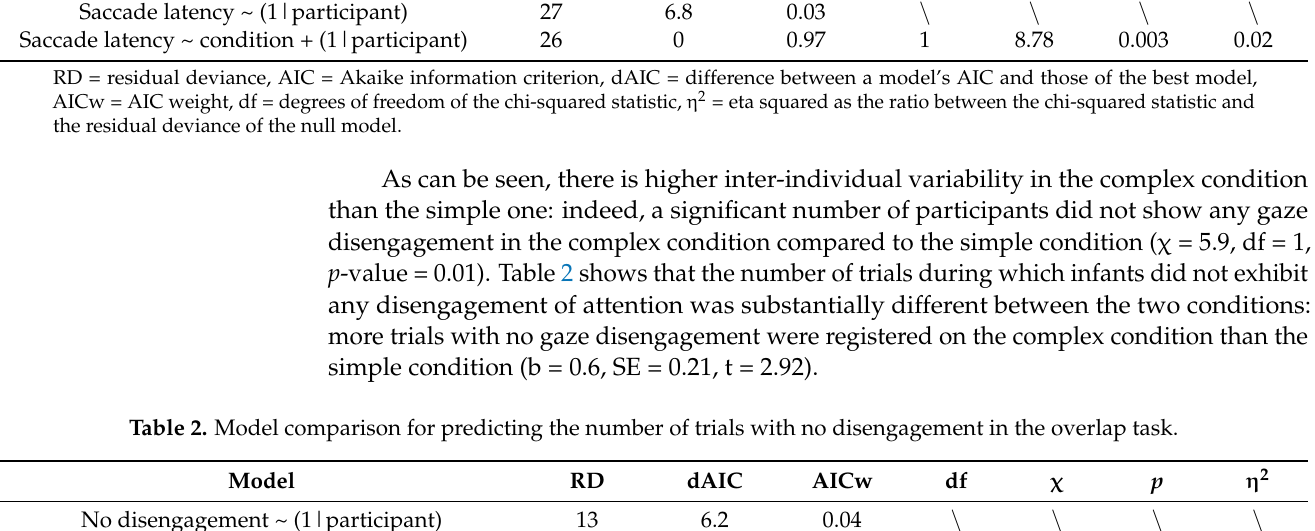
Table 1. Model comparison for predicting disengagement latency in the overlap task. Model